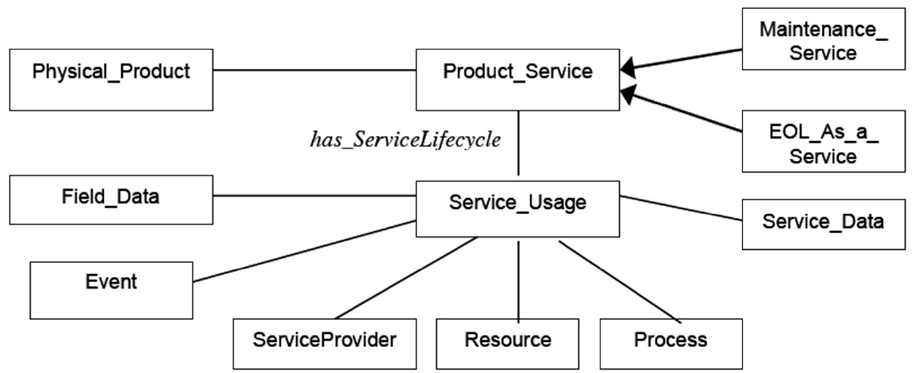
Figure 4. Product-service and the existing ontology of Physical_Product.